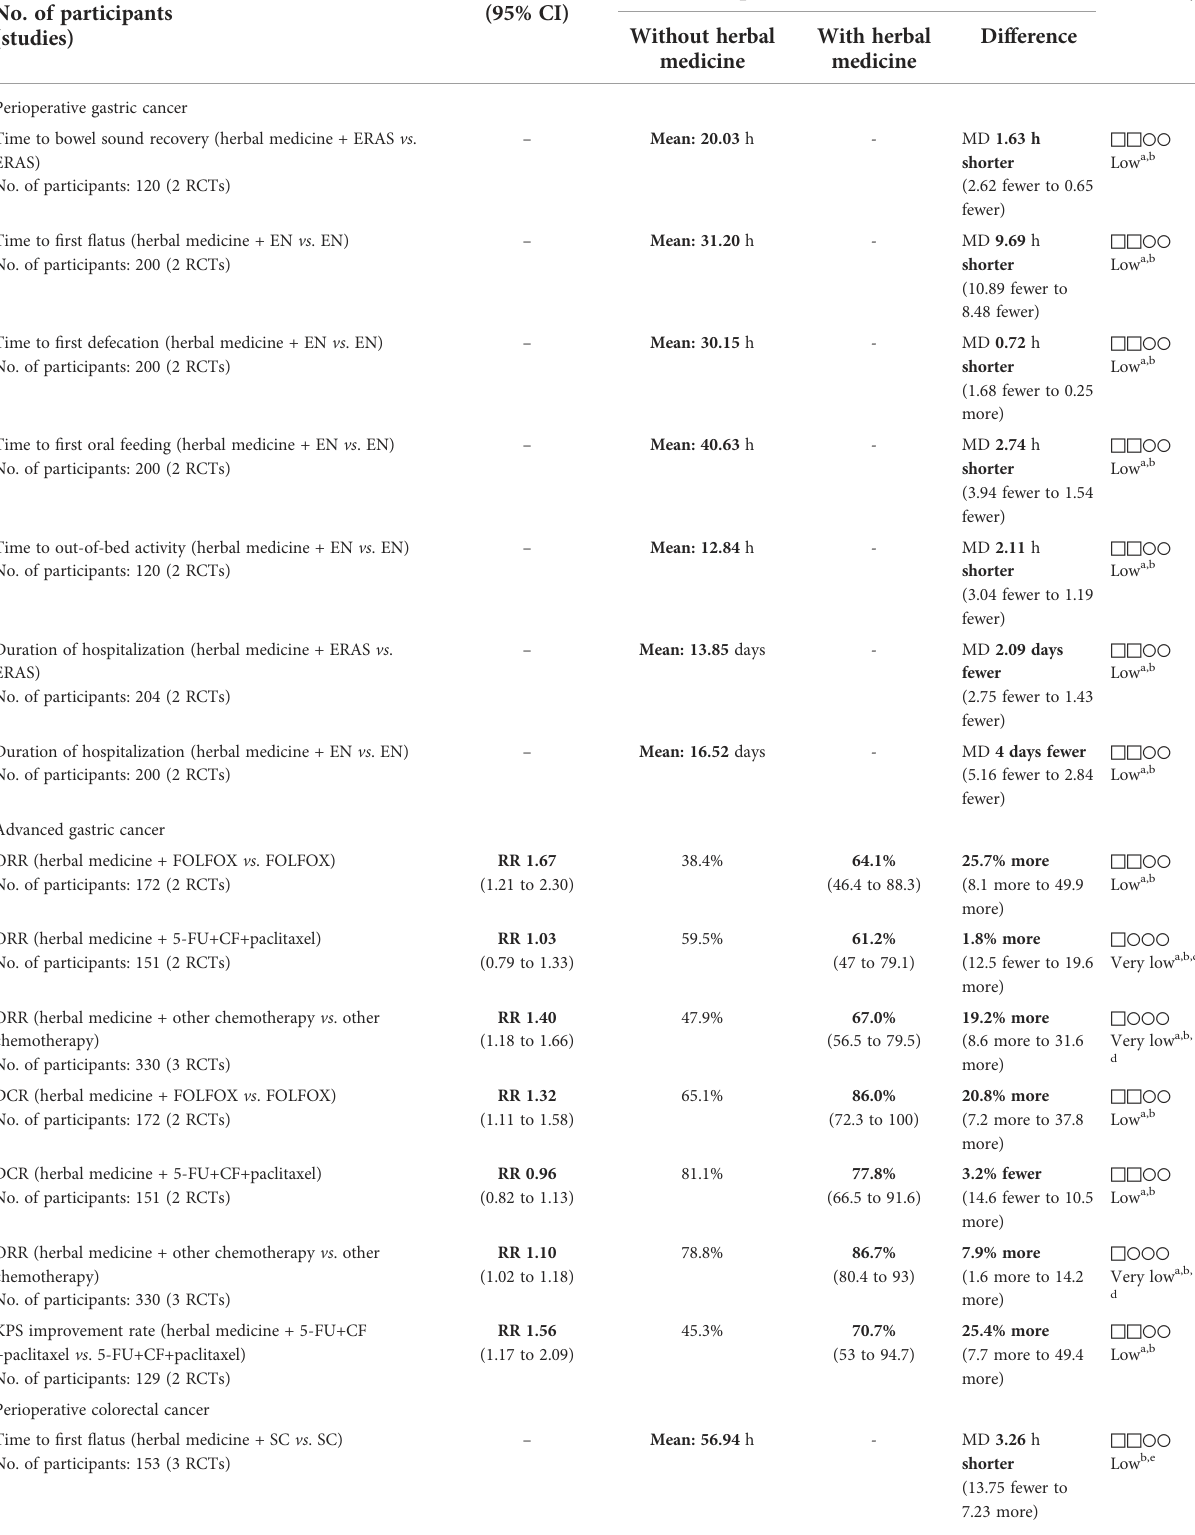
TABLE 4 Summary of fi